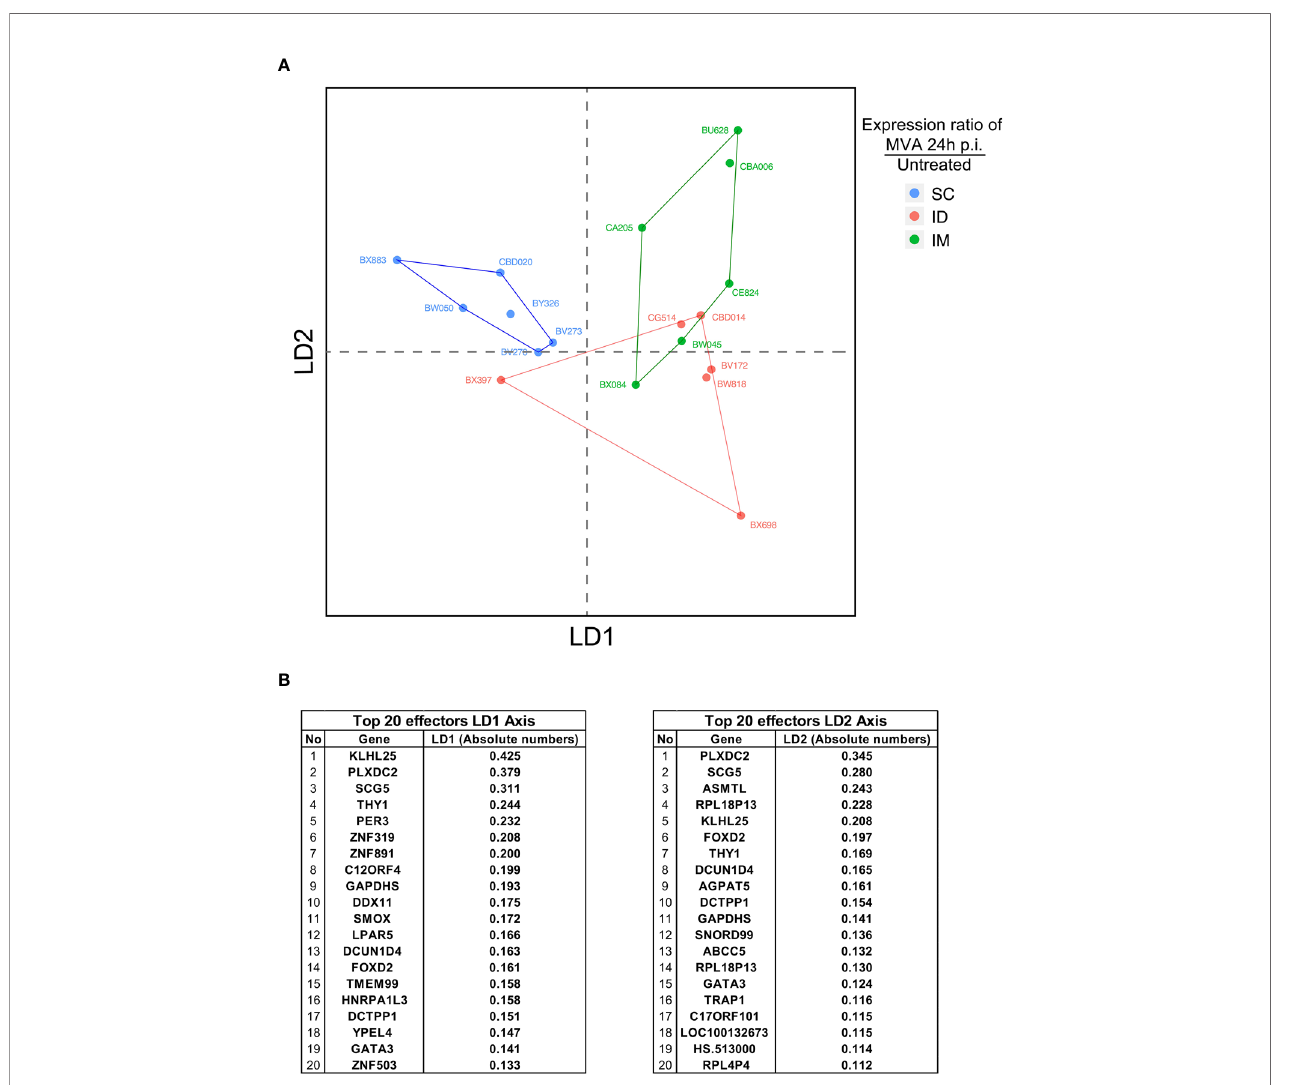
FIGURE 6 | Integrative analysis of innate immune signatures after ID/IM/SC MVA immunization. (A) LDA representation of the innate dataset after ID, IM, and SC MVA immunization. Each dot corresponds to one biological sample. Each color corresponds to one administration route. Biological samples are represented on a two-dimension scale. Differential gene expression between samples was translated into the Euclidian distance between samples. (B) Top 20 identi fi ed genes involved in the level of expression of samples on the LD1 axis and the LD2